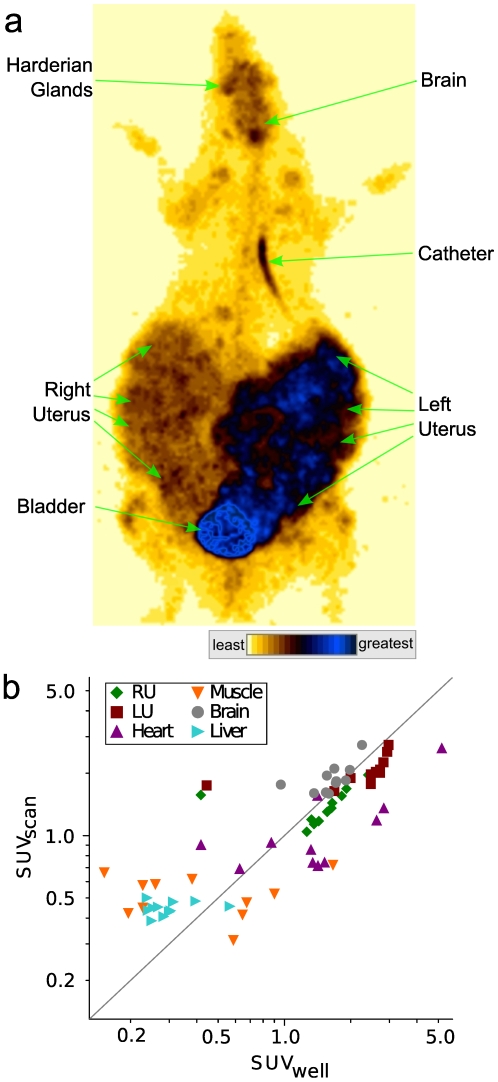
PET whole-body imaging.(a) Representative maximum intensity projection whole-body image. Color-intensity gradations are indicated from least to greatest. (b) Correlation between standardized uptake values (SUV) for volumes of interest as measured from the final whole body image (SUVscan) and for the corresponding tissues as determined by gamma well counter measurement, dose administered, and weight of the rat and the tissue (SUVwell) (r = 0.82, n = 66, p<10-16). Abbreviations: RU – right uterine horn; LU – left uterine horn.